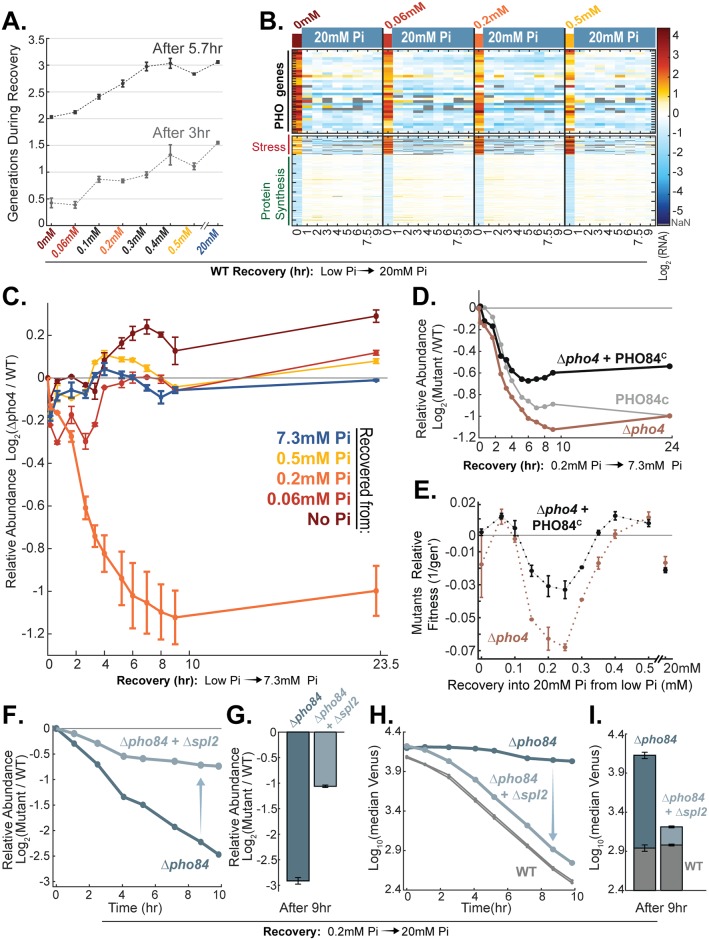
The starvation program promotes recovery once phosphate is replenished.(A) Recovery time depends on the conditions leading to starvation: Cells were incubated in media containing different low phosphate levels and maintained in the starvation conditions for 21 hours before being transferred back into a rich medium. The number of generations that cells underwent 3 or 5.7 hours after the transfer to rich medium is shown as a function of the phosphate level in the incubating media. The data in (A) are the mean and standard error of 2 replicates. (B) Pho4-target genes are rapidly down-regulated when phosphate is replenished: Recovery expression profiles of cells grown for 24.7 hours in low-Pi media (see Fig 1C) and recovered in rich medium. The data in (B) are from 1 replicate. Additional replicates for recovery from 0.2 mM and 0.06 mM Pi are found in Fig 6E and S6E Fig, respectively. See S4 Data for related experiments using a reporter gene. (C) The starvation program promotes recovery: Competition experiments, as shown in Fig 2, were performed to compare the growth of Δpho4 and wild-type cells following recovery in rich medium. Wild-type and Δpho4 cells were coincubated in media containing different levels of low phosphate, grown to saturation, and maintained in the starvation conditions for 24.7 hours before being transferred back into rich medium. The (log2) relative abundance of Δpho4 cells at different times following return to rich medium is shown. Note that Δpho4 cells are outcompeted by wild-type cells during recovery from starvation that was induced by incubation in media containing intermediate phosphate (e.g., 0.2 mM Pi). These conditions introduce the longest time gap between the first and second wave of Pho4-target gene induction (“preparation” time). The data in (C) are the mean and standard error of 2 replicates. See S4A Fig for similar experiments using Δpho81 deleted cells. (D, E) Constitutive expression of PHO84 partially rescues the recovery phenotype of Δpho4 cells: Experiments as shown in (C) were repeated for cells that constitutively express the PHO84 transporter (PHO84C) in a wild-type or Δpho4 background. The (log2) relative abundance of mutant cells during recovery from starvation induced by incubating in media containing 0.2 mM Pi is shown in (D). In (D), the mean of 2 replicates is shown for Δpho4, and 1 replicate is shown for PHO84C with and without Δpho4. These data are supported by the experiments shown in (E) and Fig 5B. (E) The experiments in (D) were repeated using a variety of starvation media, and the fitness difference of mutant and wild-type cells was measured following 24.7 hours of incubation in rich medium. This fitness difference is shown as a function of the initial phosphate level in the starvation media. Note that deletion of PHO4 impaired recovery when cells were first incubated at intermediate phosphate levels (around 0.2 mM Pi), allowing sufficient preparation time, and that constitutive expression of PHO84 partially rescued this phenotype. The data in (E) are the mean and standard error of 3 replicates. See S4B Fig for similar experiments using Δpho81 cells. (F–I) Phosphate influx limits recovery from starvation: Competition experiments as in (C) were repeated for cells of the indicated genotype (F–I). Shown are the (log2) relative abundance of the indicated mutant strains (F–G) and the level of the PHO84p-Venus reporter in the mutants and wild-type cells (H–I) during competitive growth. In (F, H) are shown several time points within the first 10 hours of recovery (into 20 mM Pi), and those after 9 hours of recovery into 20 mM Pi are shown in (G, I). The data in (F, H) are from 1 replicate and are supported by data in (G, I), which show the mean and standard error of 2 replicates. See (S4C and S4D Fig) for recovery into a high Pi of 7.3 mM Pi. The raw data for (C, D, and F–I) are available in S4 Data. The raw data for (A, B, and E) are available in S1, S2 and S5 Data, respectively. NaN, not a number; Pi, inorganic phosphate; WT, wild type.